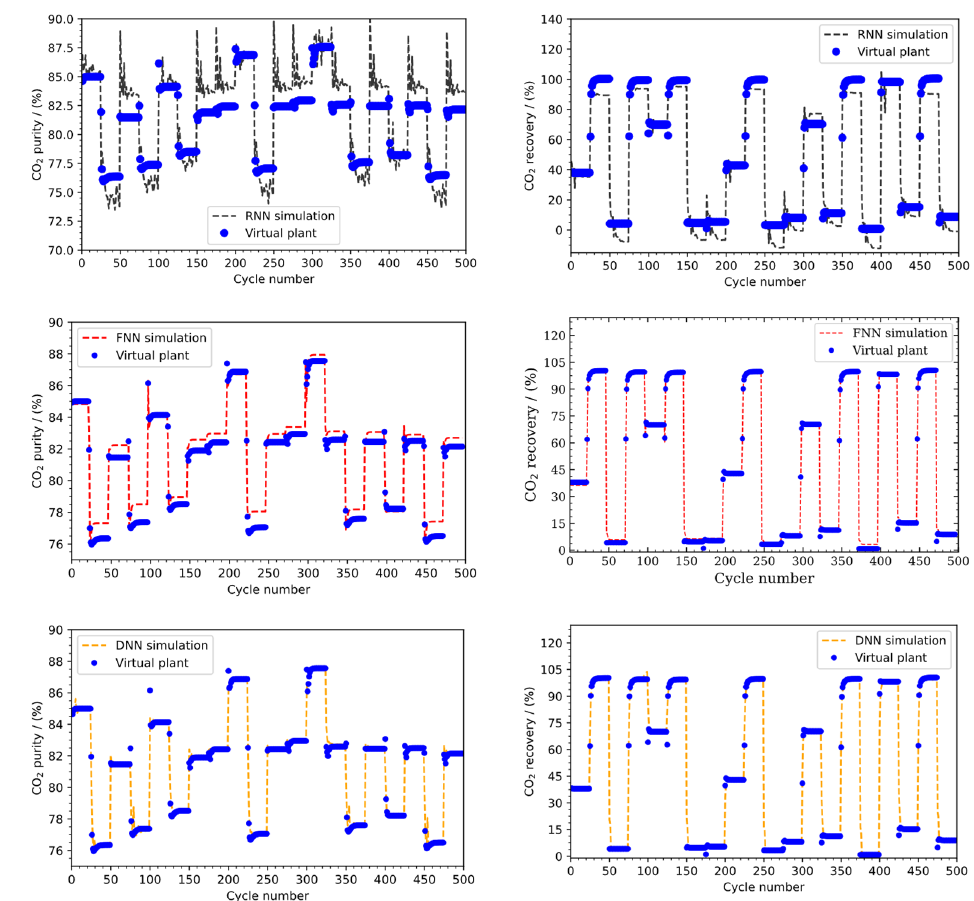
Figure 11. Simulation of the PSA operating from several different operating conditions.